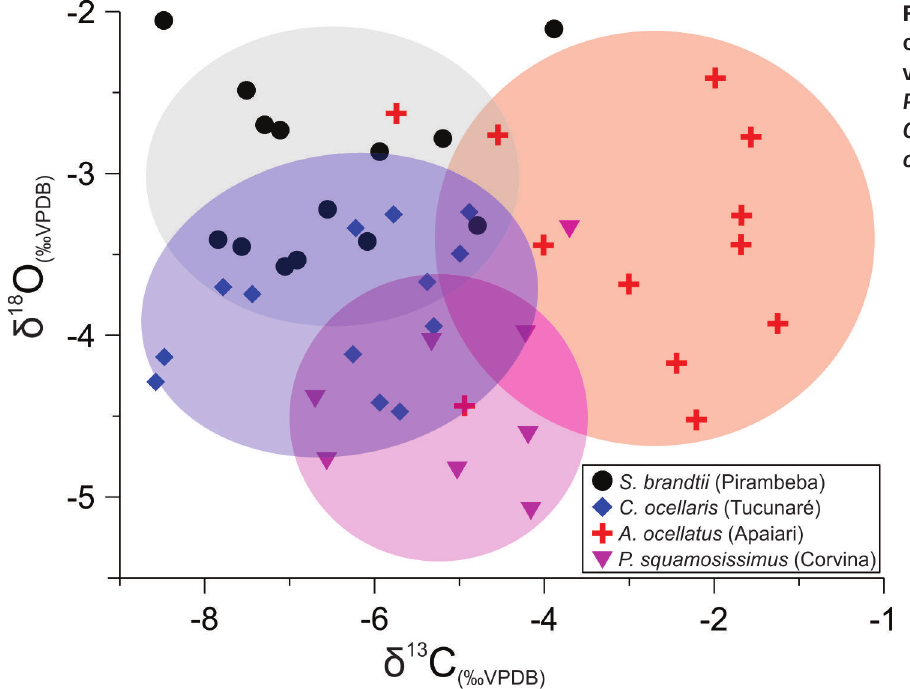
Figure 3. Cross plot of the δ 13 C and δ 18 O values of S. brandtii , P. squamosissimus , C. ocellaris, and A. ocellatus